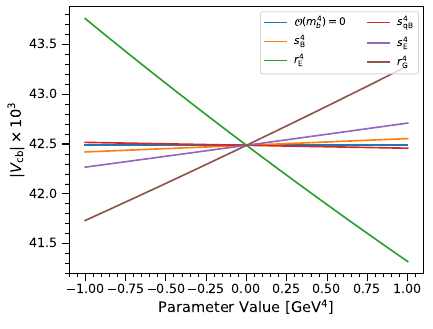
HQE terms independently between b